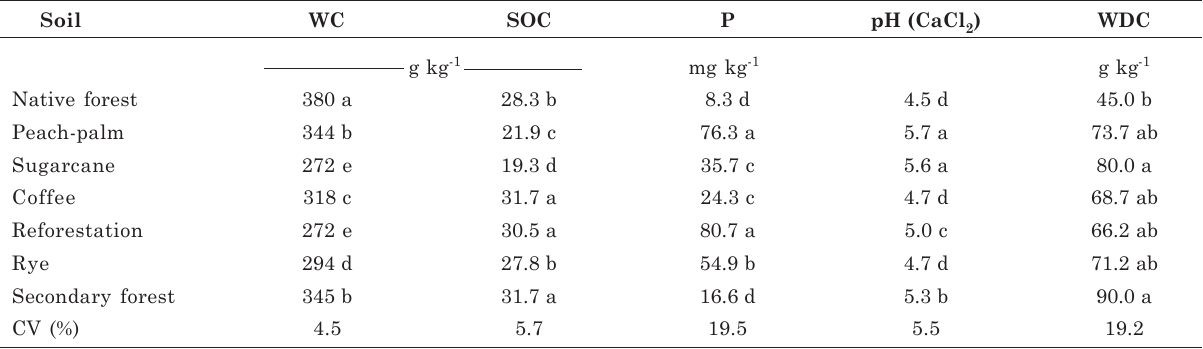
The same letters in the columns do not differ from each other by the Scott-Knott test at